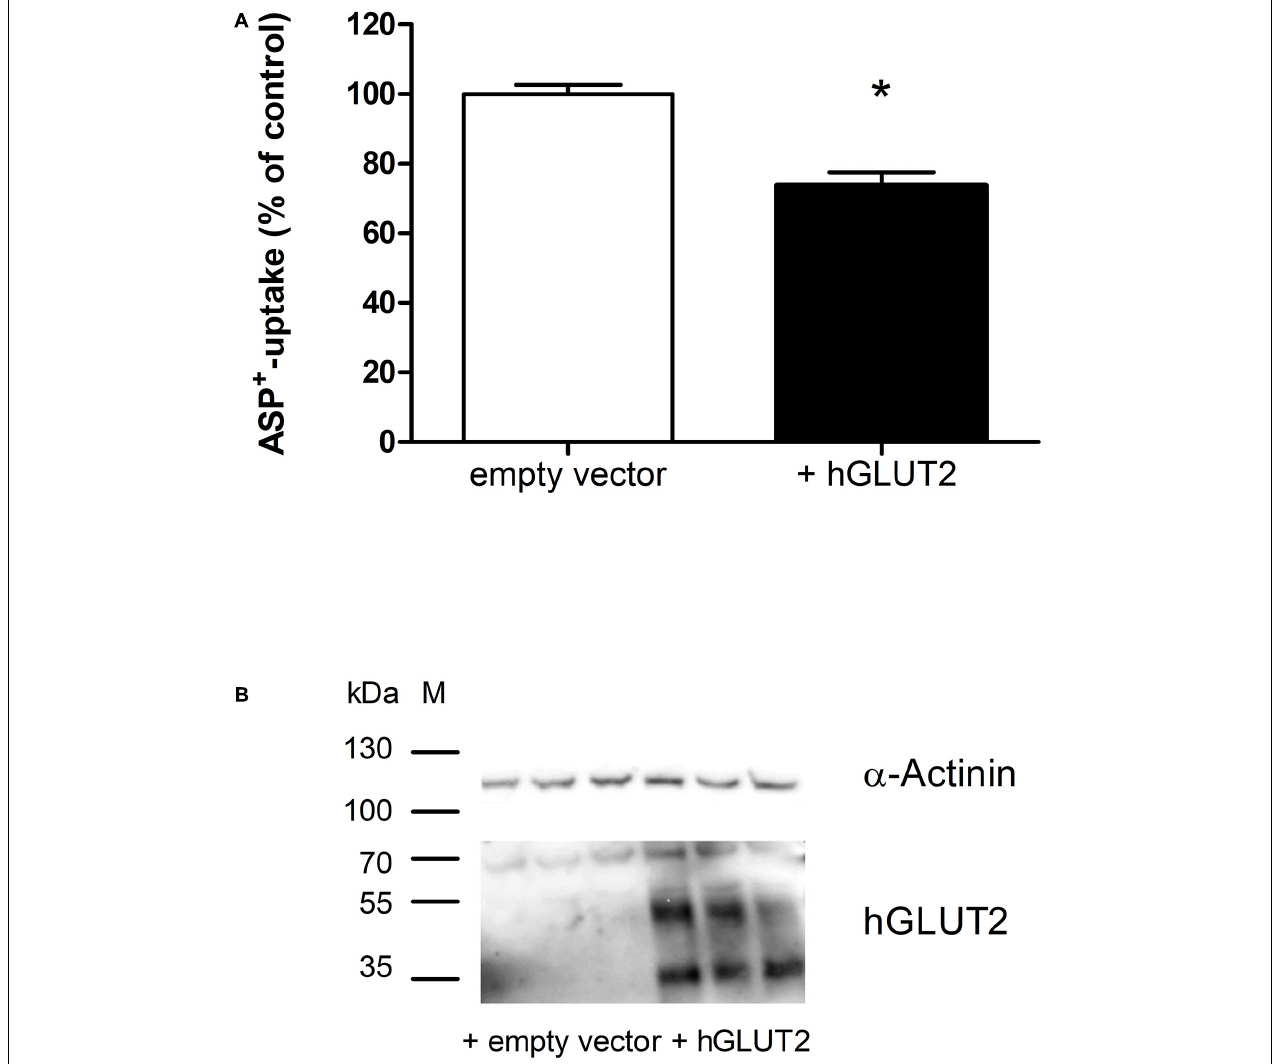
FIGURE 3 | Transfection of HEK cells stably expressing hOCT2 with GLUT2: effects on the ASP + uptake. Panel (A) shows the uptake of 1 µ M ASP + in HEK cells 72 h after transfection with GLUT2 or empty vector (EV). Overexpression of GLUT2 significantly inhibited ASP + uptake (*, unpaired t -test, 27 replicates measured in three independent experiments). Panel (B) shows the western blot analysis of GLUT2 72 h after transfection. α -Actinin was used as loading marker. This antibody against hGLUT2 is known to detect mature glycosylated hGLUT2 at 60-70 kDa, non-glycosylated hGLUT2 at 38–45 kDa, and a hGLUT2 fragment at around 35 kDa (https://www.ptglab.com/products/SLC2A2-Antibody-20436-1-AP.htm). All these bands are visible in this western blot analysis, especially in HEK cells transfected with hGLUT2, confirming that transfection with hGLUT2 was successful. Bands corresponding to GLUT2 were observed mainly in transfected cells.